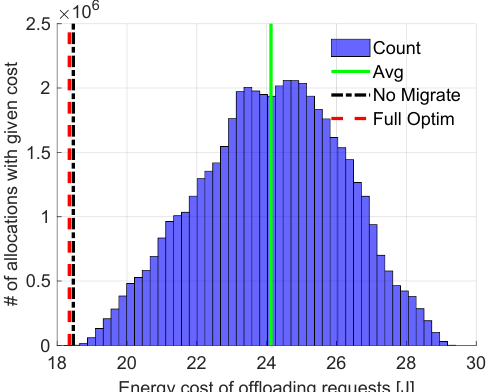
Figure 3. Comparison of our (Full Optim) solution with the No Migrate solution and all possible allocations from exhaustive search (blue bars; average value marked with solid green